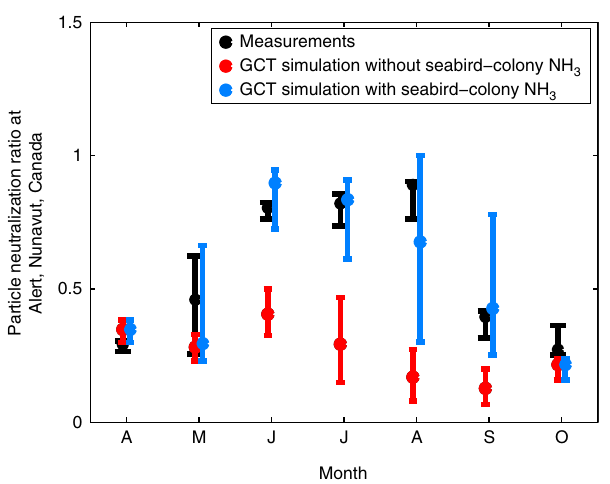
Figure 3 | Aerosol neutralization state at Alert. Monthly median (April to October) aerosol neutralization ratios from filter measurements (black) at Alert, Nunavut, Canada and for the GEOS-Chem-TOMAS (GCT) simulations with (blue) and without (red) seabird-colony NH 3 emissions. Error bars show the 20th and 80th percentiles.